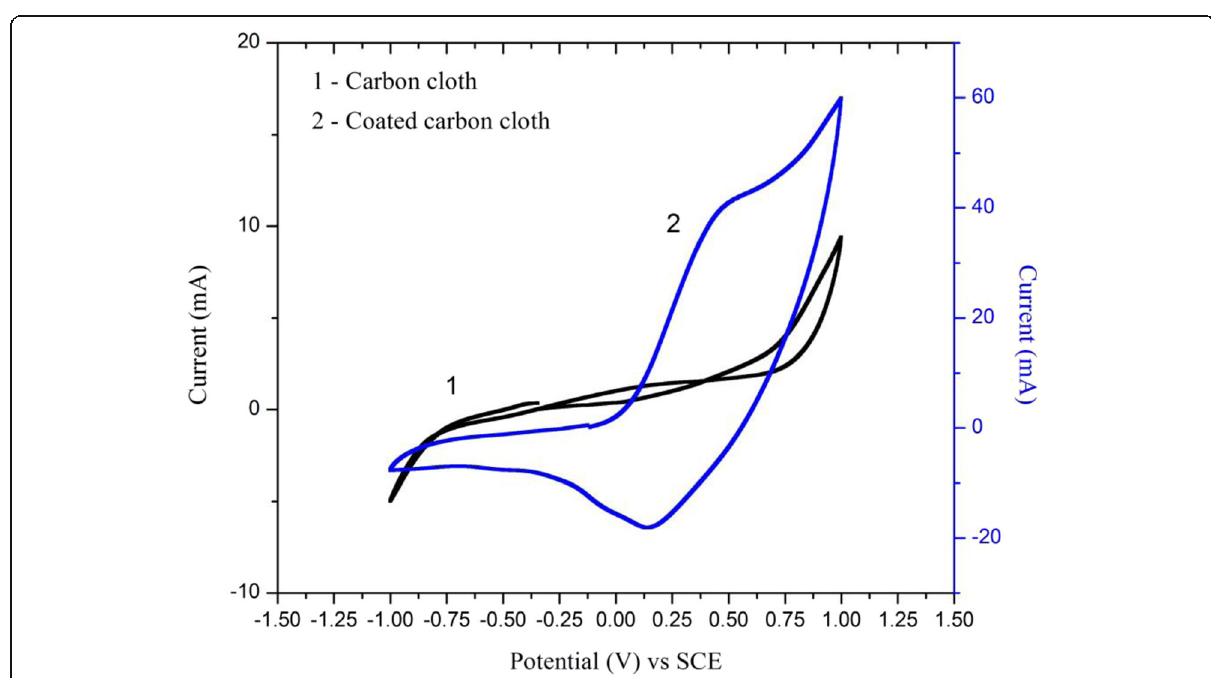
Fig. 4 Cyclic-voltammetry characteristics for plain carbon cloth and coated carbon cloth